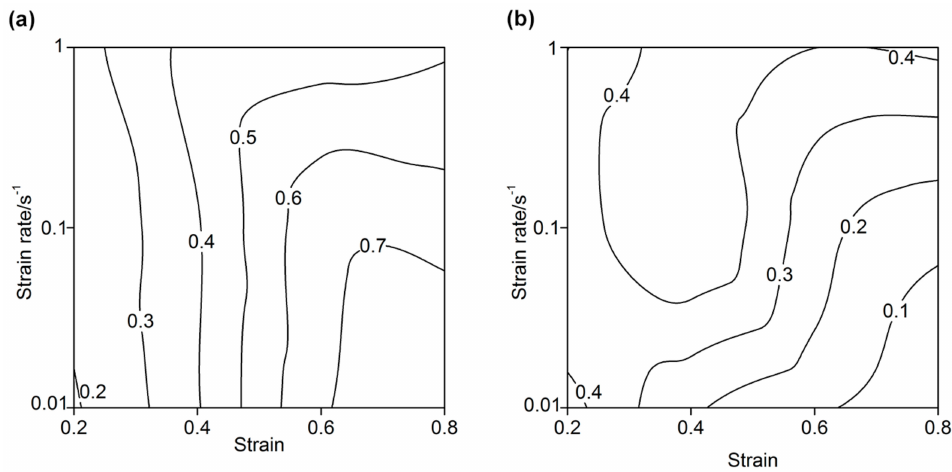
Figure 3. Fractions of <100> and <111> fiber textures under different strains and strain rates corresponding to Figure 2, the compressing temperature is 1153 K: ( a ) <100> fraction distribution; ( b ) <111> fraction